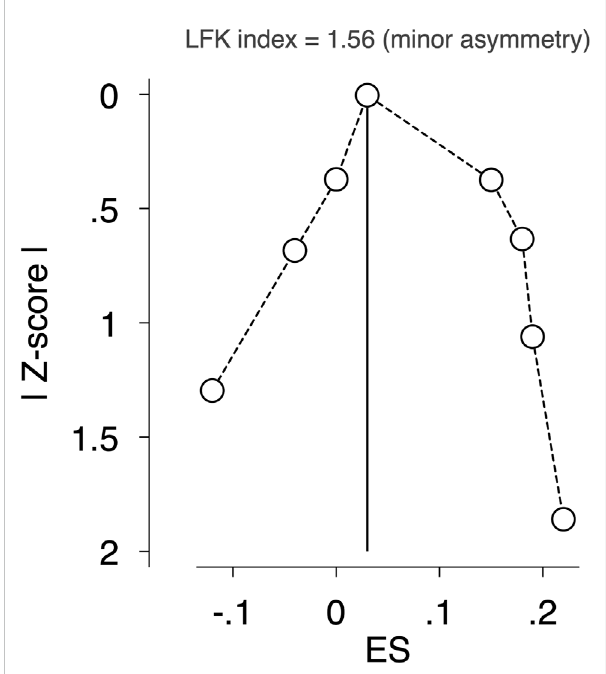
FIGURE 5 Assessment of potential publication bias by LFK index. Abbreviations: RCT, randomised controlled trial; WB, whole body; LS, lumbar spine; FN, femoral neck; aBMD, areal bone mineral density; vBMD, volumetric bone mineral density; BMAD, bone mineral apparentdensity;BMC,bonemineralcontent;SDS,standarddeviation scores; NR, Not